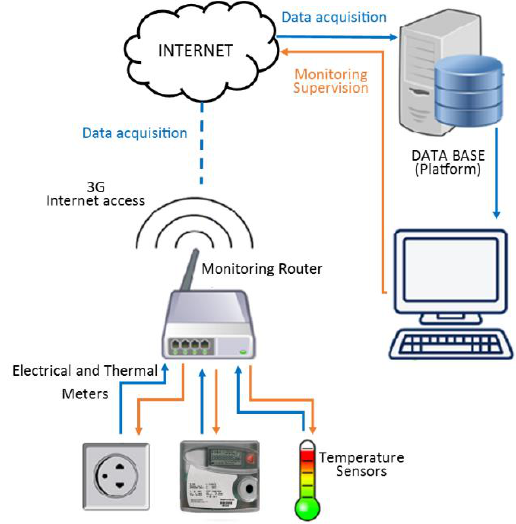
Figure 1. Data collection diagram.